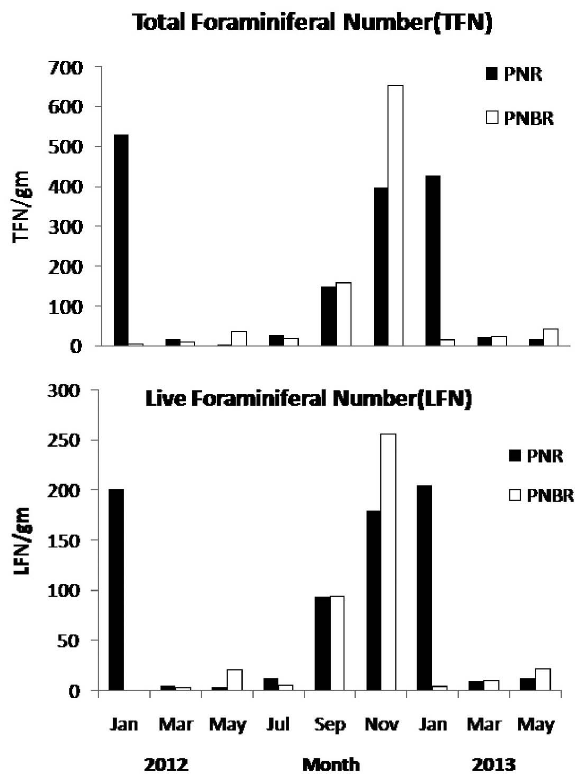
Fig 2. – A, total foraminiferal number, B, live foraminiferal number at Site 1, Payyannur (PNR), and Site 2, Panambur (PNBR).